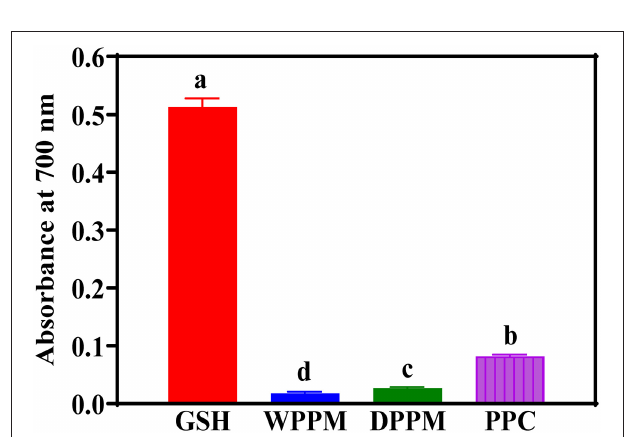
FIGURE 4 | Ferric reducing antioxidant power activities of different peanut protein preparations (WPF, whole peanut flour; DPPM, defatted peanut protein meal; PPC, peanut protein concentrate) in comparison to glutathione (GSH) a natural antioxidant. Values are means ± std and bars with different letters are significantly at p <